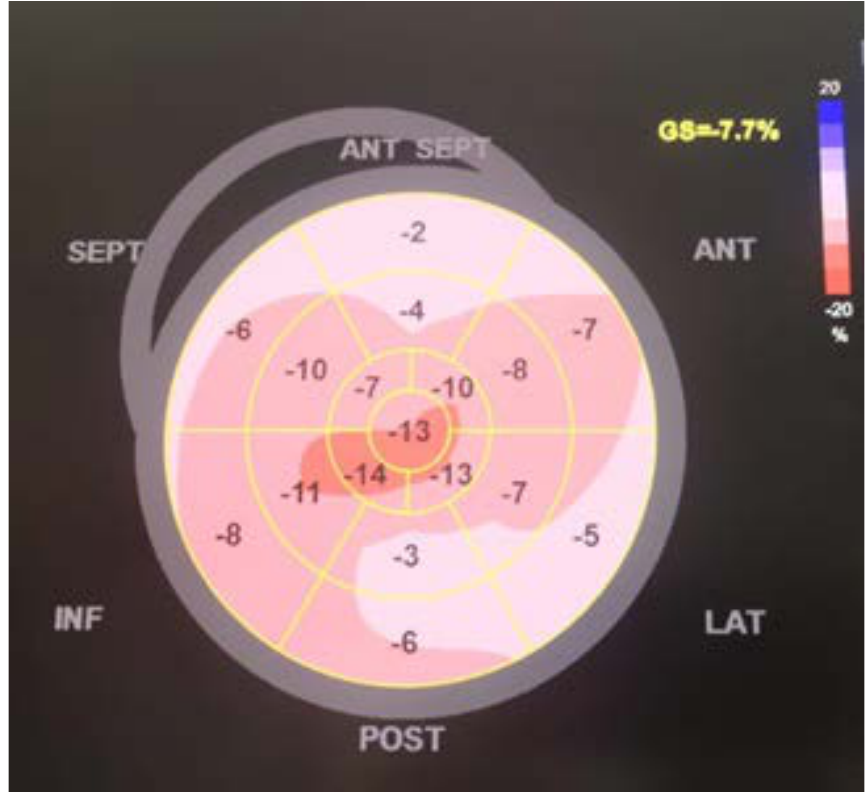
Figure 2. Global strain (GS) of the left ventricle: polar map with the regional values and the GS value calculated from the 17 segments of the left ventricle, which is significantly impaired (ANT, anterior; ANT SEPT, anteroseptal; GS, global strain; INF, inferior; LAT, lateral; POST, posterior; SEPT, sep- tal).